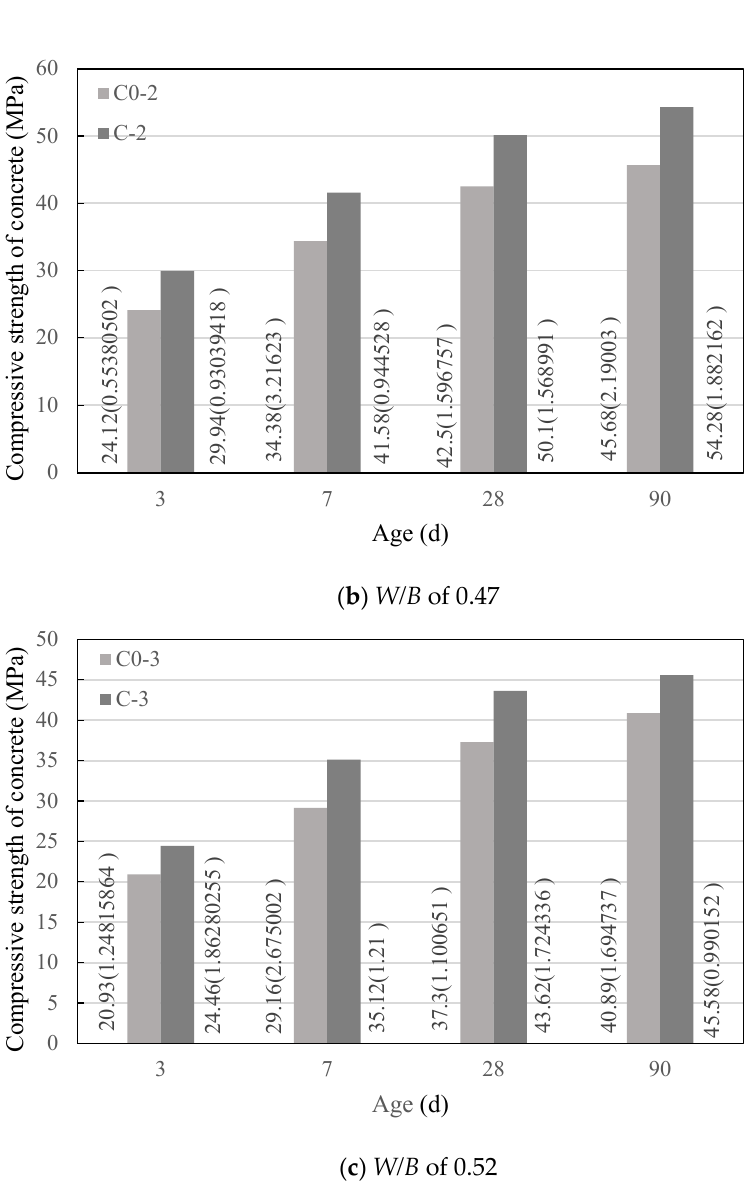
Figure 2. Compressive strength of concrete. It can be seen from Figure 2 that under water–binder ratios of 0.42, 0.47, and 0.52, the development law of the compressive strength of concrete in group C with age was basically consistent with the development law of the compressive strength of control concrete (C0) with age, and the compressive strength of concrete in both groups increased with the extension of the age. At the same age, the changing law of compressive strength of concrete in group C with the water–binder ratio was the same as the changing law of compressive strength of concrete in group C0 with the water–cement ratio. The compressive strength of concrete in both groups decreased with the increase in water–cement ratio; however, when the water–binder ratio was 0.42, 0.47, or 0.52, the compressive strength of concrete in group C was higher than that of the control concrete with the same water–binder ratio. The growth rate of the compressive strength of concrete is shown in Table 8. It can be seen from Table 8 that the concrete with a water–binder ratio of 0.42 had the highest growth rate of compressive strength at each age, followed by the concrete with a water–binder ratio of 0.47 and then 0.52. Except for a single point, it can be said that the smaller the water–binder ratio, the greater the growth rate of compressive strength at each